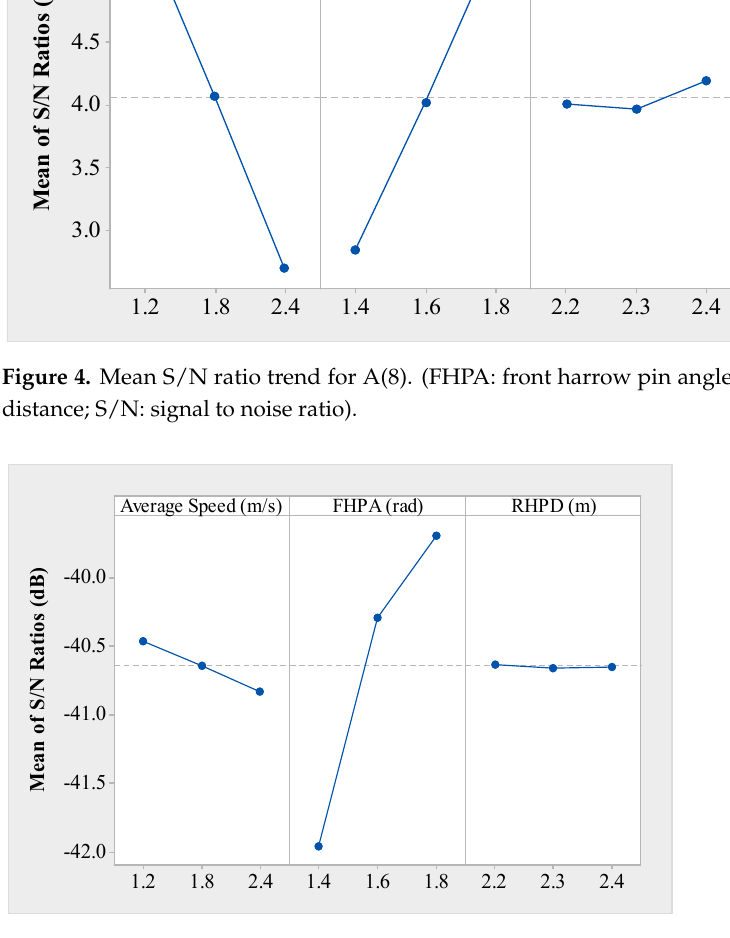
Figure 5. Mean S/N ratio trend for SEAT%.